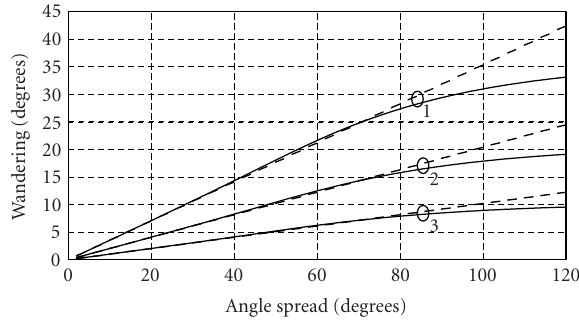
Figure 4: The source C of G wandering versus angle spread ∆ for the di ff erent numbers of scatterers N = 1,3,12 (curves 1, 2, 3, re- spectively). The solid and dashed curves correspond to the exact formula (8) and its Gaussian approximation (9),